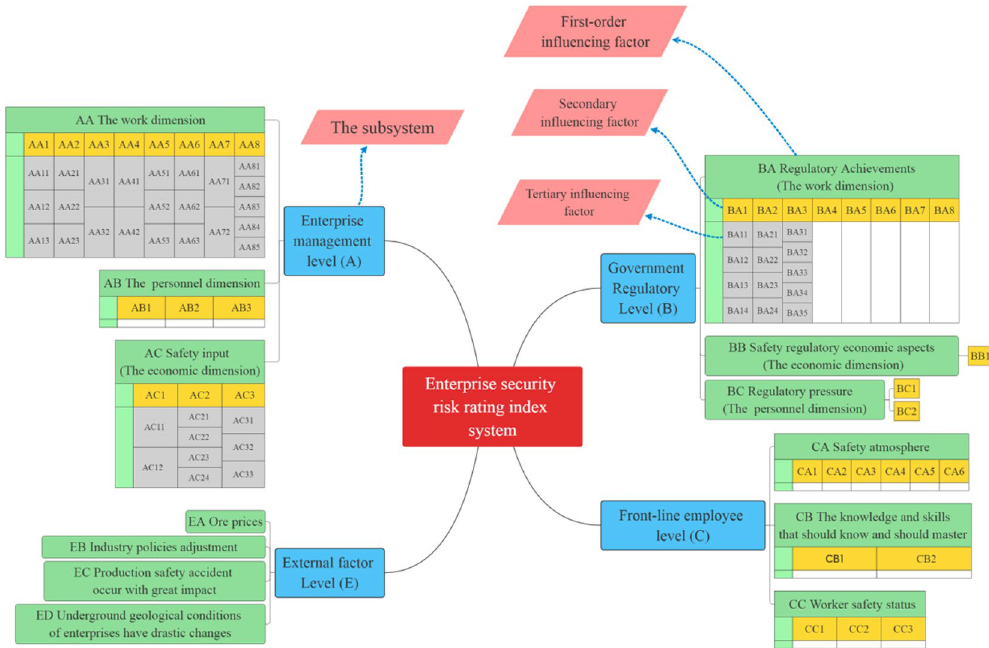
Figure 3. Safety risk evaluation index system of